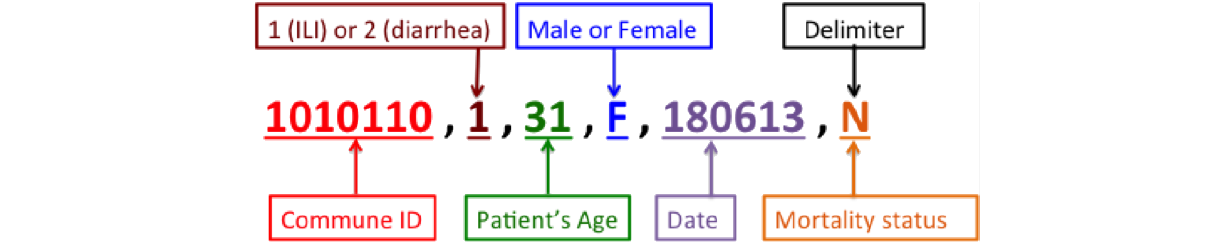
Figure 2. The structure of the SMS text message report in the first